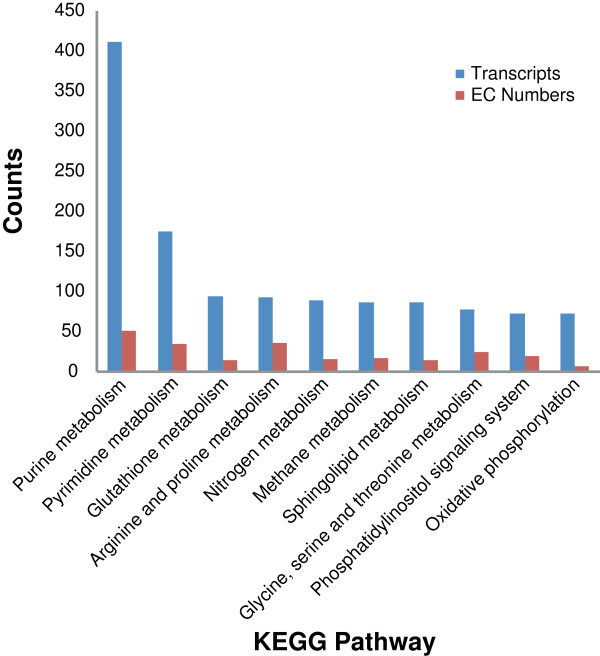
KEGG pathway annotations. Top 10 represented KEGG pathways using EC (Enzyme Commission) annotations, derived from GO annotations. Shown is the number of transcripts matching to each pathway and the number of EC numbers represented in the pathways.